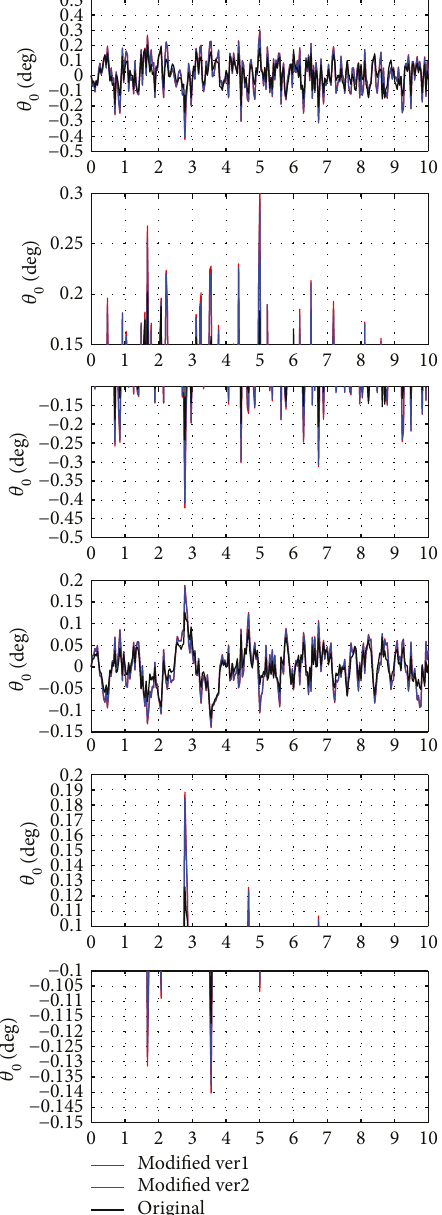
Figure 8: E ff ect of simultaneous variations in blade root chord and blade taper on some controls for 40-knot